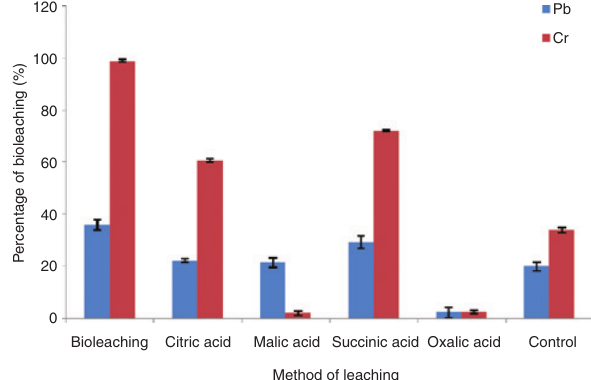
Figure 4: Comparing the removal percentage of heavy metals between A. flavus (F3) bioleaching and chemical